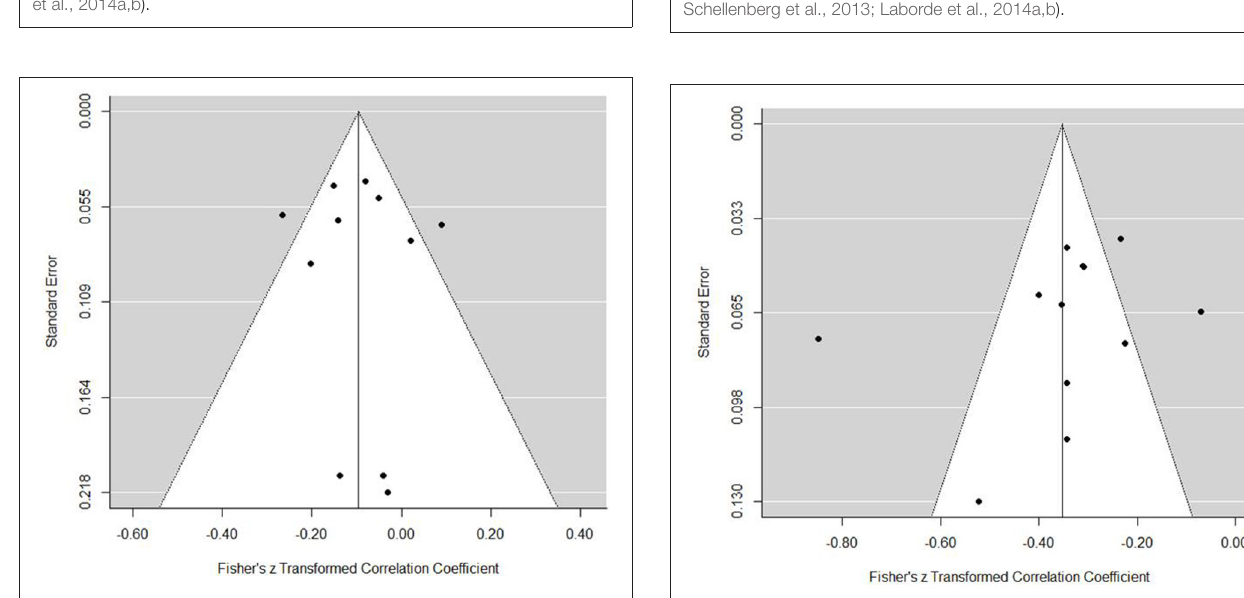
FIGURE 8 | Goal withdrawal coping funnel